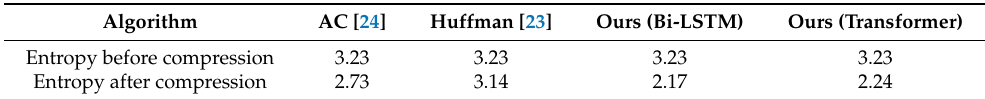
Table 4. Test the entropy of a group of 200-min current data before and after compression in different